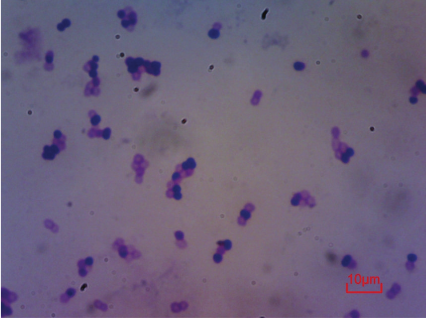
Figure 2: Cell morphology of isolated rhizospheric strain, Suzhou 08+6, under microscopy × 1000 (Gram staining